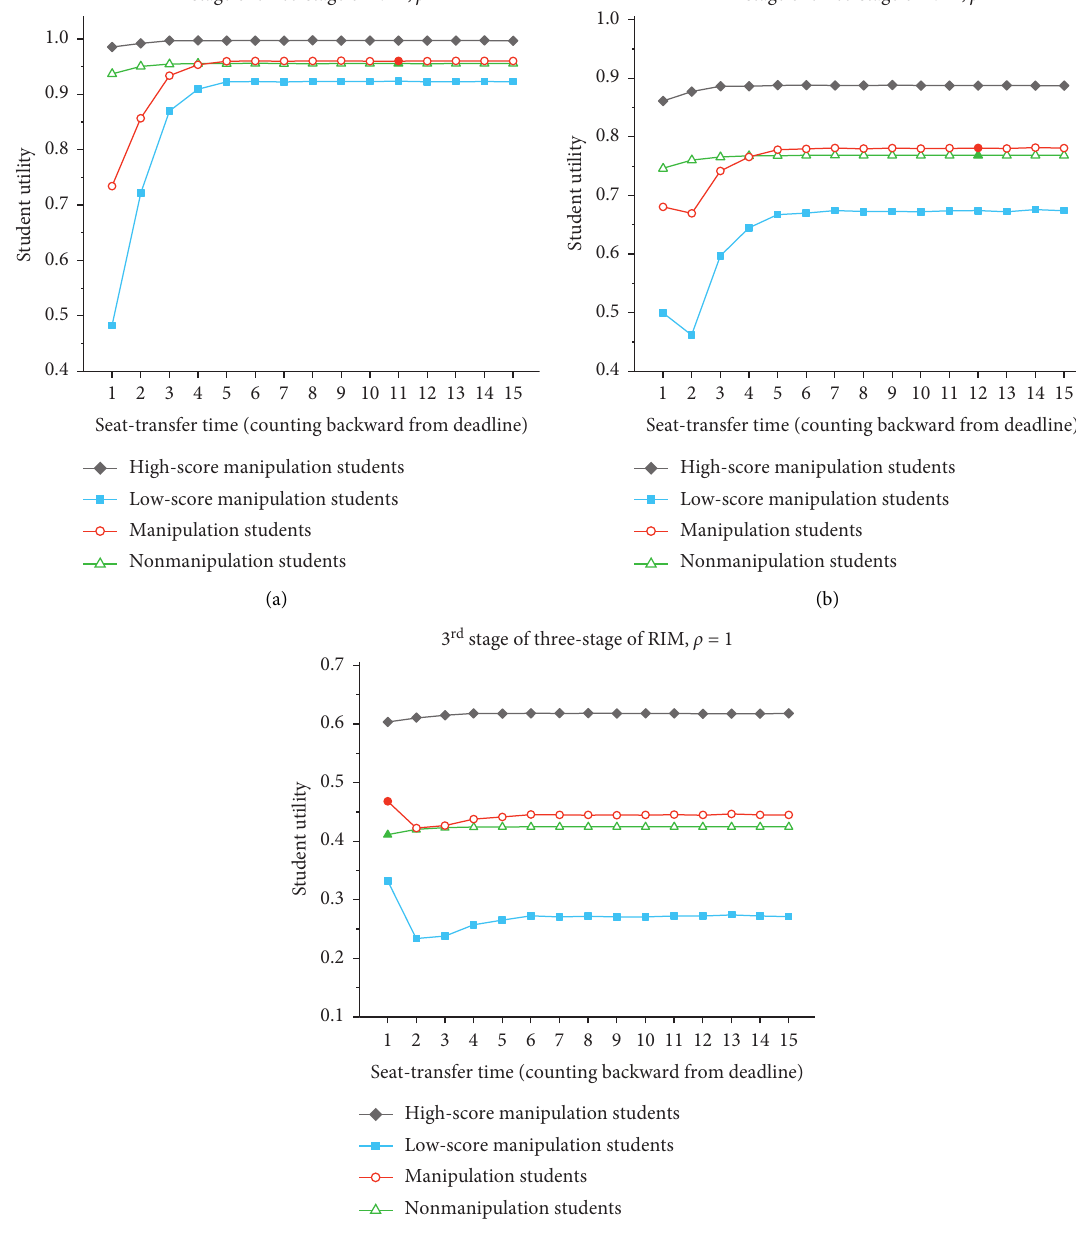
Figure 6: The utilities of manipulation students and nonmanipulation students when the manipulation students transfer the seat at different